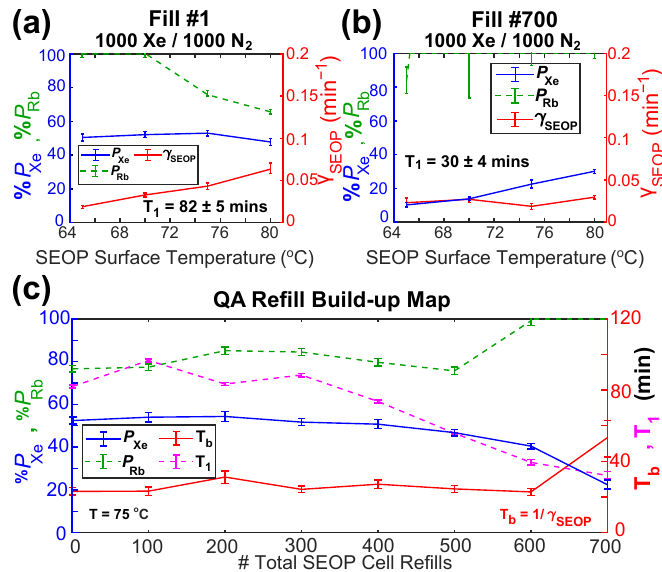
Figure 6. ( a ) Steady-state % P Xe , γ SEOP , and % P Rb measurements as a function of cell jacket temper- ature following fill #1 (the initial 1000 Torr Xe/1000 Torr N 2 gas mixture fill at the commencement of the QA study). ( b ) Steady-state % P Xe , γ SEOP , and % P Rb measurements as a function of SEOP cell surface temperature following fill #700 (the final gas fill of the QA study); note the reduction in % P Xe and T 1 values. ( c ) Steady-state % P Xe , % P Rb , and T b measurements after polarization build-up at a SEOP cell surface temperature of 75 ◦ C, as well as post-build-up T 1 relaxation measurements, plotted versus the number of total gas mixture refills. The solid lines are added to guide the